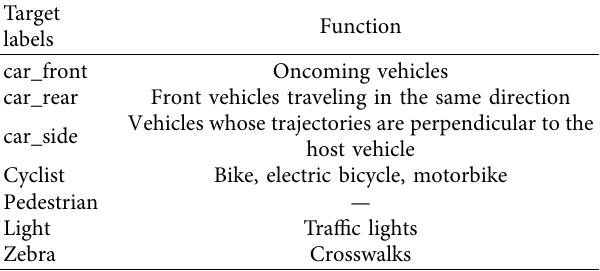
Table 1: Target labels and corresponding descriptions.